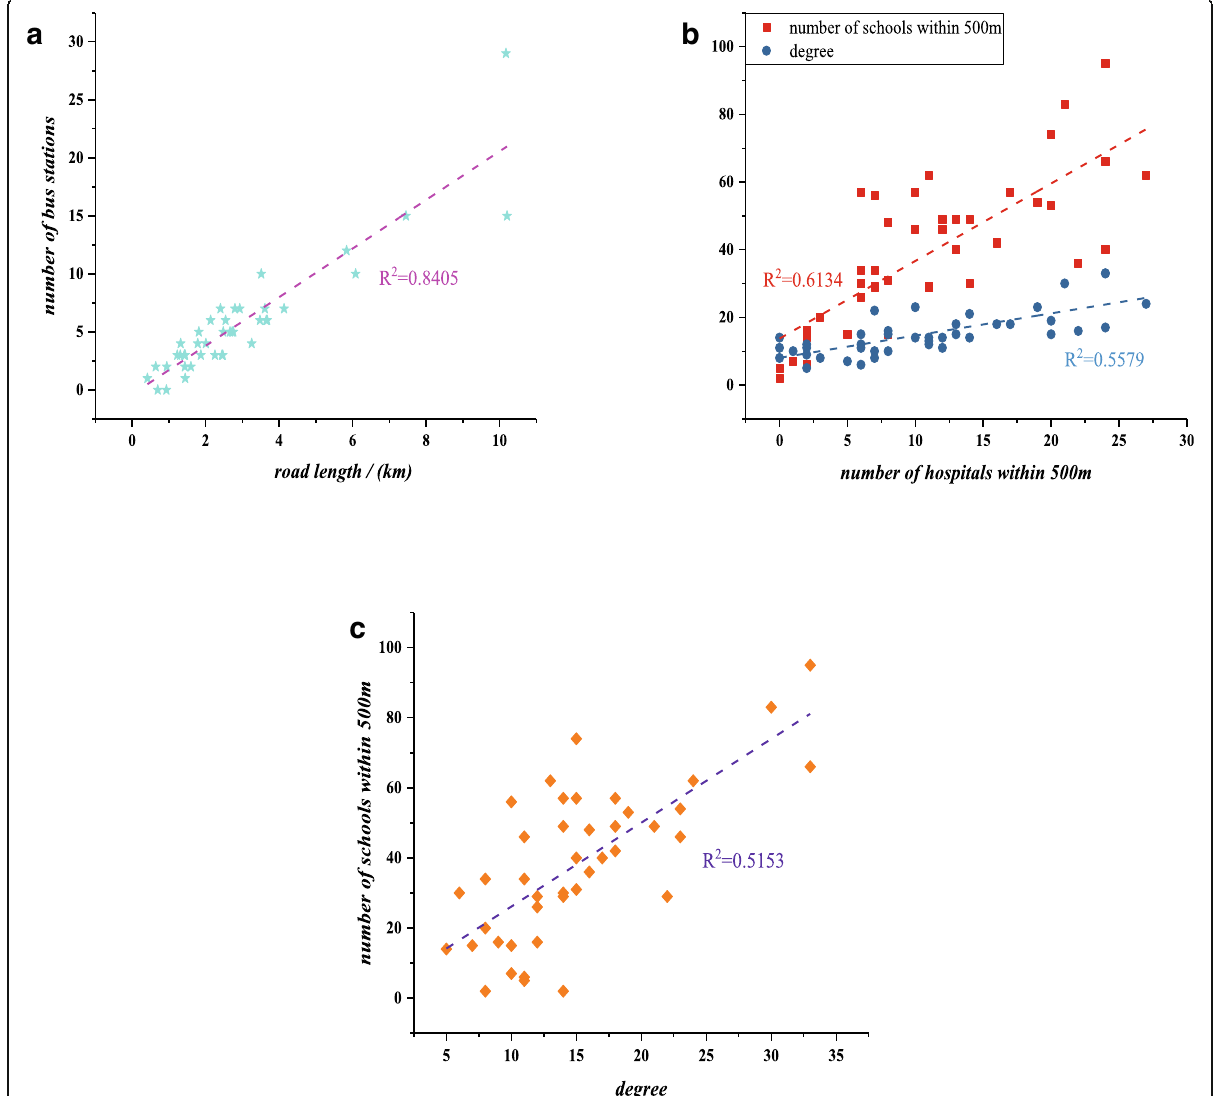
Fig. 12 Correlation analysis of built environment factors: ( a ) road length and number of bus stations; ( b ) number of hospitals within 500 m, number of schools within 500 m and degree; ( c ) degree and number of schools within 500 m